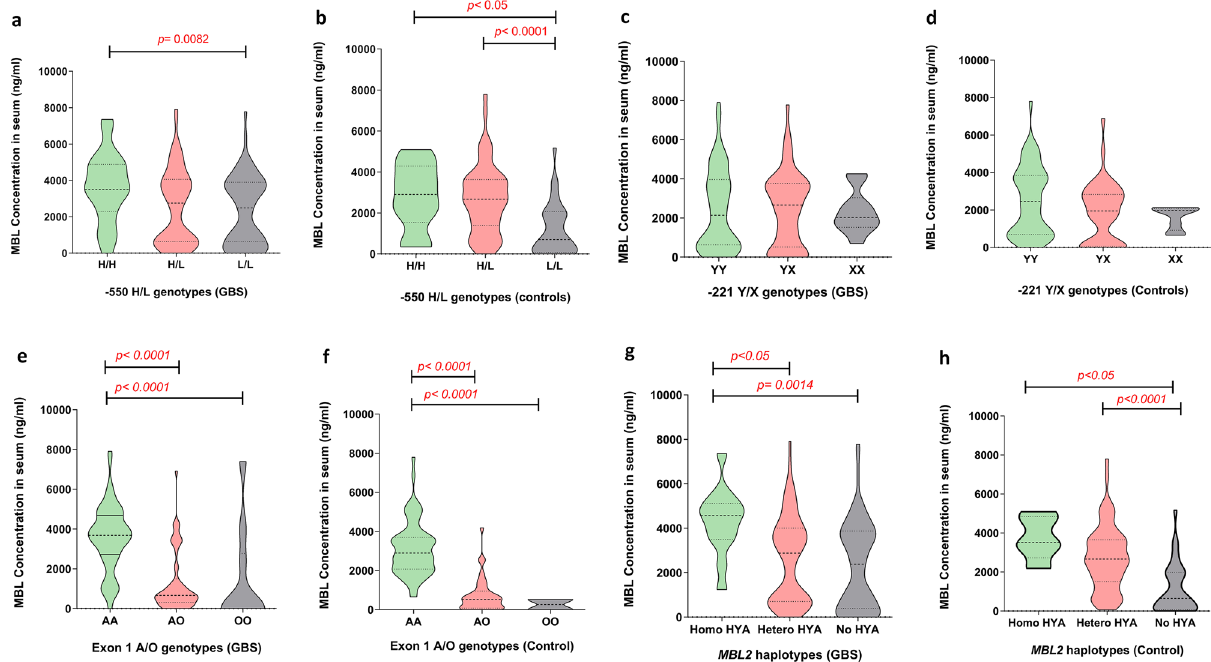
Figure 2. Association of serum MBL levels with MBL2 genotypes in patients with GBS and healthy controls. ( a–d) Associations between the promoter − 550H/L and − 221X/Y SNPs and serum MBL levels, ( e,f) association between functional region exon 1 SNPs and serum MBL levels, and ( g,h) association between HYA haplotypes and serum MBL levels. The violin plots indicate interquartile (Q3-Q1) ranges with the minimum and maximum values; P < 0.05 were determined with Kruskal–Wallis test and the kernel density estimate depicts the multimodal probability